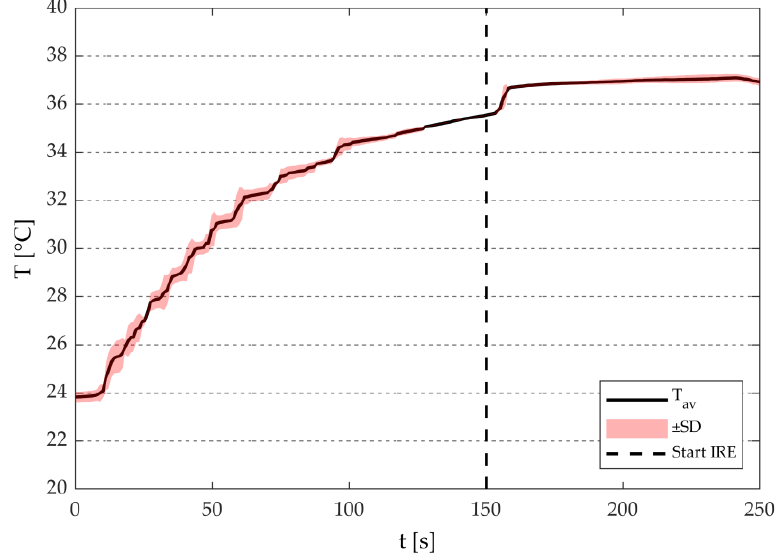
Figure 6. An illustration of the average temperature evolution over time (T av ; n = 3) during the treatment at 37 ◦ C for 1250 V · cm − 1 . The solid line represents the average temperature, pink area represents the standard deviation ( ± SD), and the dashed line represents the start of the IRE treatment.